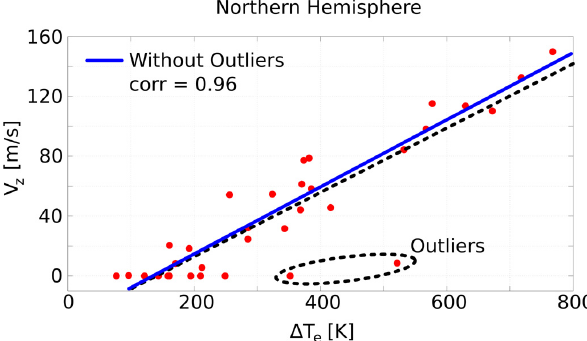
Fig. 8. Correlation analysis results between ion vertical velocity V z and electron temperature rise 1T e in the Northern Hemisphere. The regression line and correlation coefficient (“corr”) apply to the total data set independent of